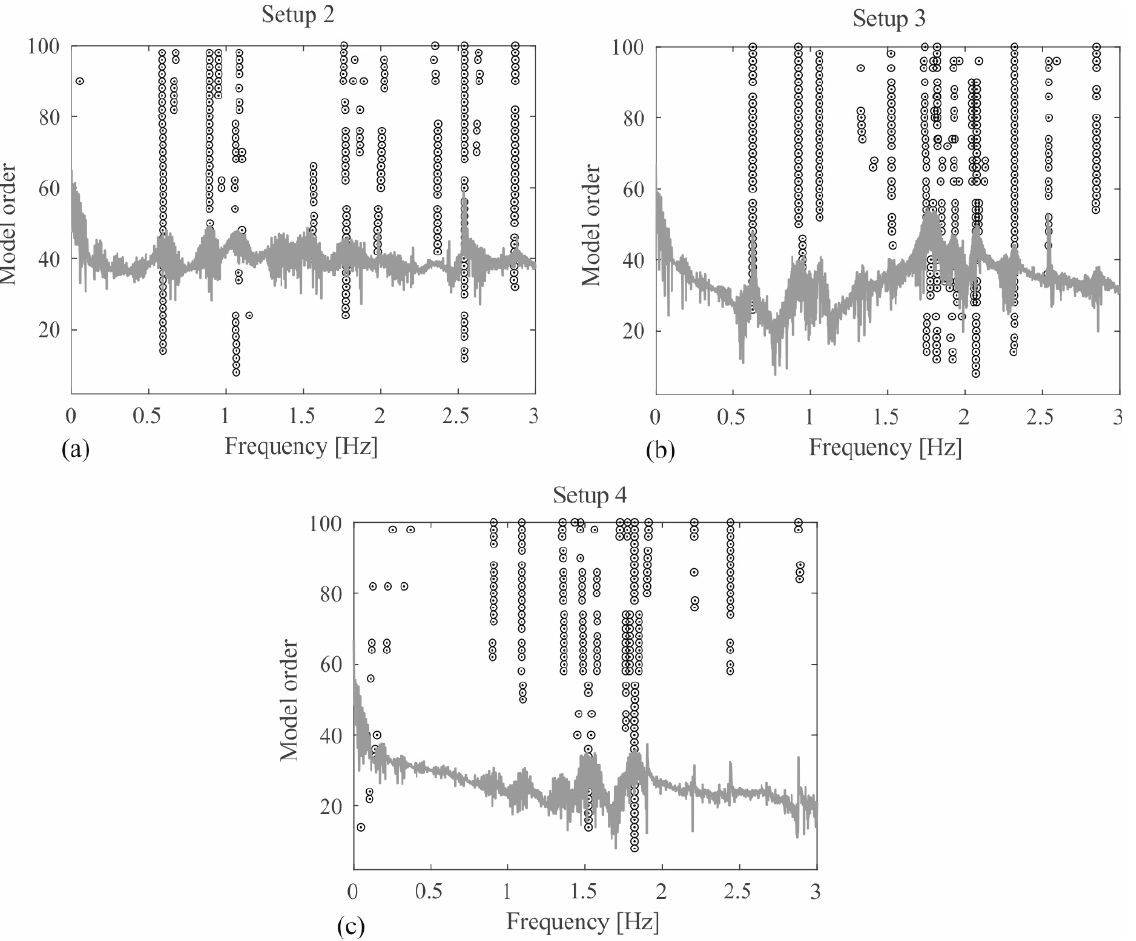
Figure 8. Stabilization diagrams of Setups 2 (a), 3 (b) and 4 (c) obtained from the SSI technique and power spectral density functions of the measured accelerations (in grey).